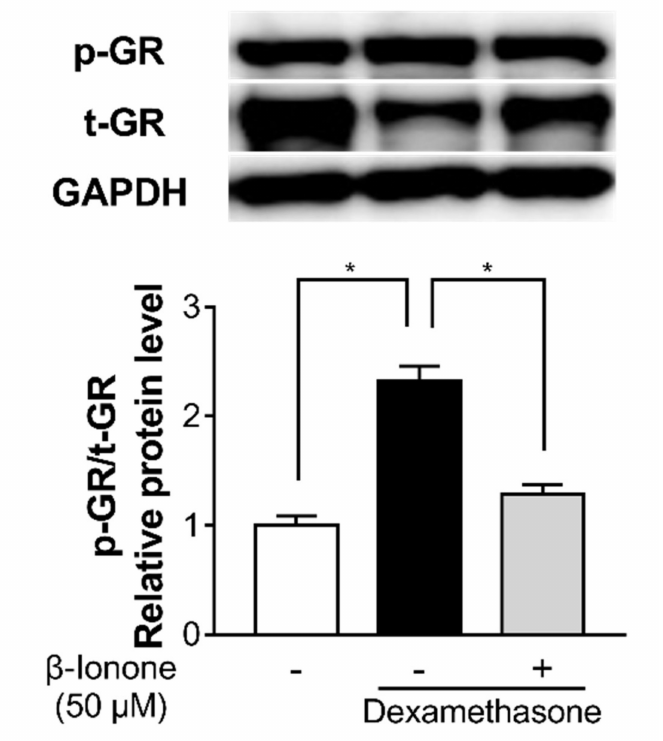
Figure 5. Effect of β -ionone on GR signaling. Human dermal fibroblasts were treated with either vehicle (shown as “-”) or β -ionone (shown as “+”) as well as dexamethasone for 30 min. Whole-cell protein extracts were prepared and analyzed by Western blotting. The levels of phosphorylated GR and total GR were normalized to the level of GAPDH, and then the ratio of phosphorylated/total GR was calculated. The ratio of phosphorylated GR to total GR is presented (p-GR/t-GR). Values are shown as mean ± standard error of the mean (SEM) of three experiments. Statistical significance is expressed as follows: * p <